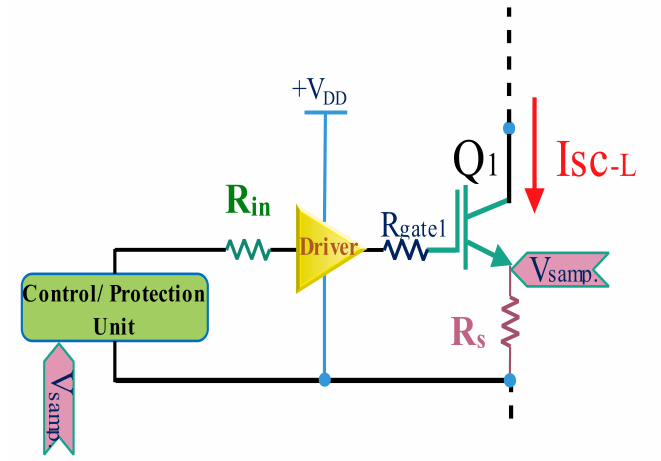
Figure 1. The schematic of the proposed method for limiting IGBT peak current.